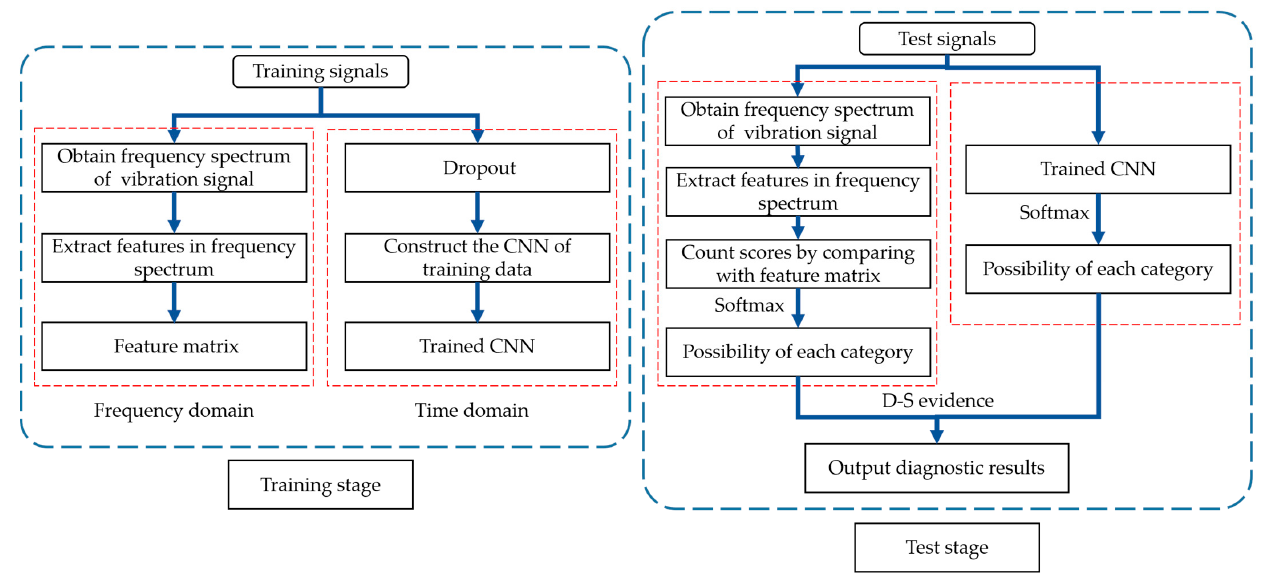
Figure 1. Structure of fault diagnosis method proposed in this paper.